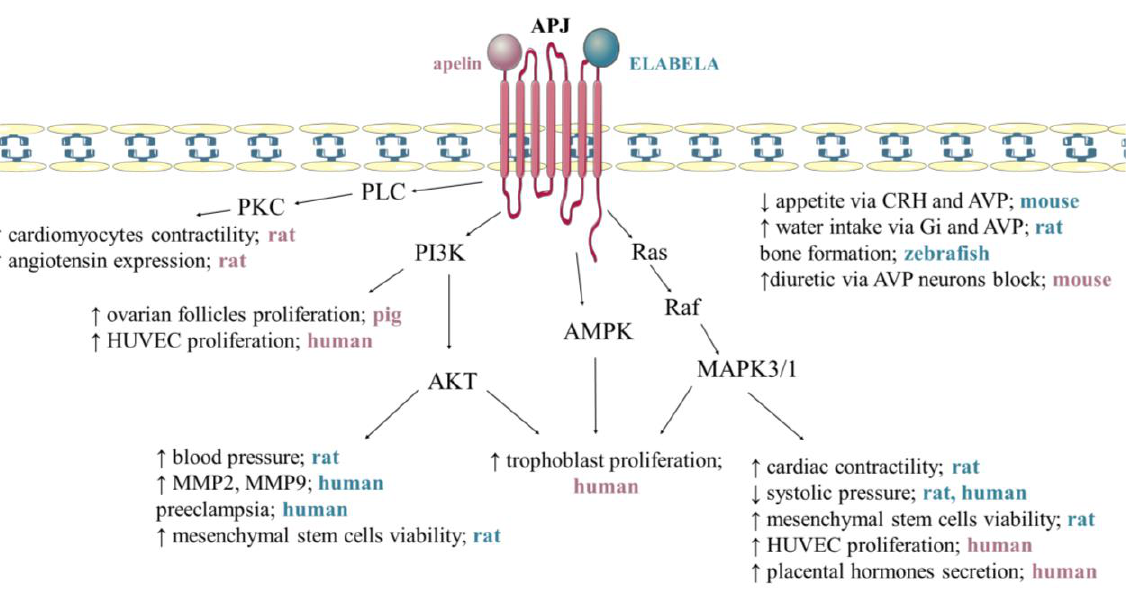
Figure 3. Mechanism of apelin and ELABELA action via APJ receptor. Apelin activates phospholipase C/protein kinase C (PLC/PKC) signalling pathway, increasing cardiomyocyte contractility [57] and angiotensin expression [62]. Apelin stimulates the proliferation of ovarian follicles [42], trophoblast [63], and human umbilical vein endothelial cells (HUVEC) [60] via phosphoinositide 3-kinase/protein kinase B (PI3K/AKT), Raf kinase/serine-threonine-specific protein kinases/mitogen-activated protein kinases (Ras/Raf/MA PK3/1) and 5′AMP -activated protein kinase (AMPK), additionally increases placental hormones secretion [64] and shows diuretic via AVP neurons block [13]. ELABELA increases blood pressure [49], mesenchymal stem cells viability [65], matrix metalloproteinase-2 (MMP2), matrix metallopeptidase-9 (MMP9) [46] via PI3K/AKT. ELABELA activates kinases MAPK/1/3 increases cardiac contractility [47] and decreases systolic pressure [26,46], additionally reduces appetite via cortycoliberin (CRH) and AVP (arginine vasopressin) [46], increases water intake via Gi and AVP [50] and affects bone formation [13]. Stimulation, ↑ ; inhibition, ↓ . The pink lettering refers to apelin. The blue text refers to ELABELA.